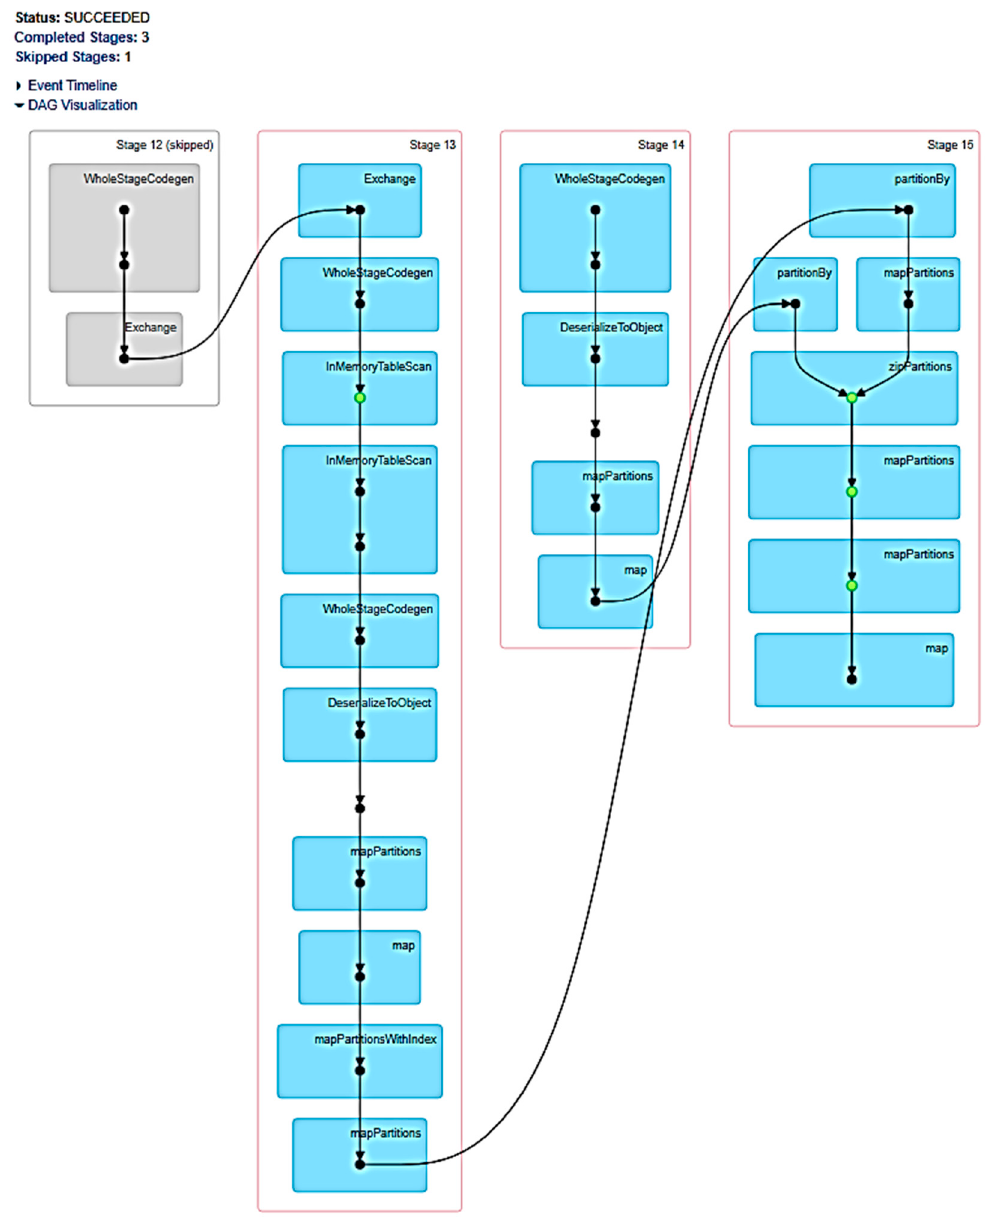
Figure A1. An example of SCC algorithm DAG for a job with three stages.